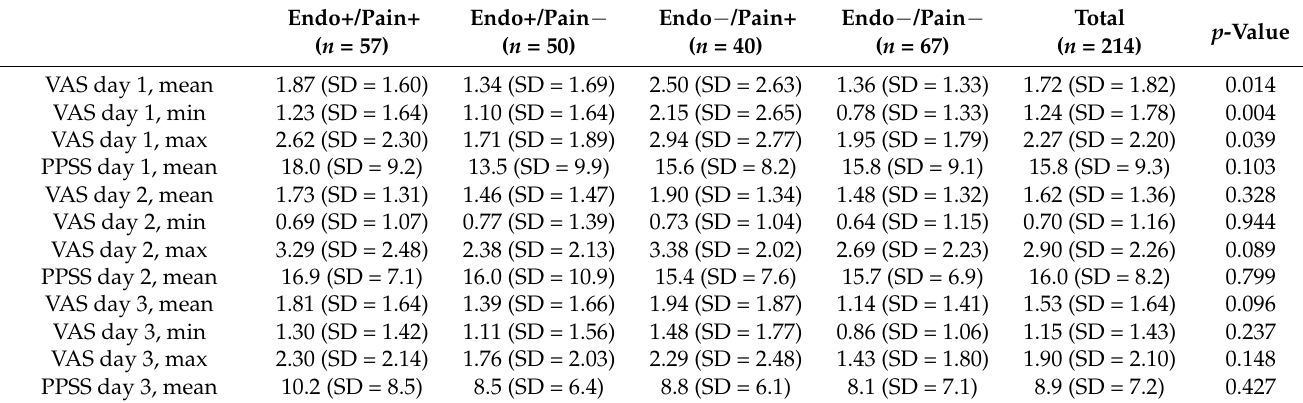
Table 3. Postoperative pain using the VAS score and the PPSS.